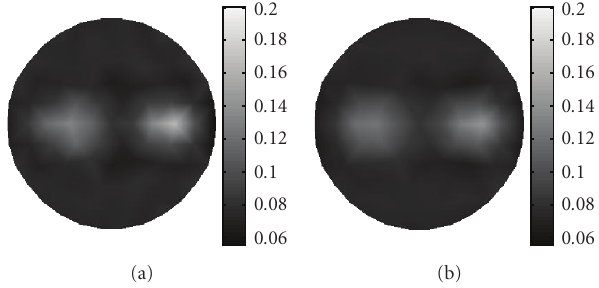
Figure 4: Reconstructed image of absorption coe ffi cient due to fluorophore μ axf with (a) proposed algorithm, and (b) method in